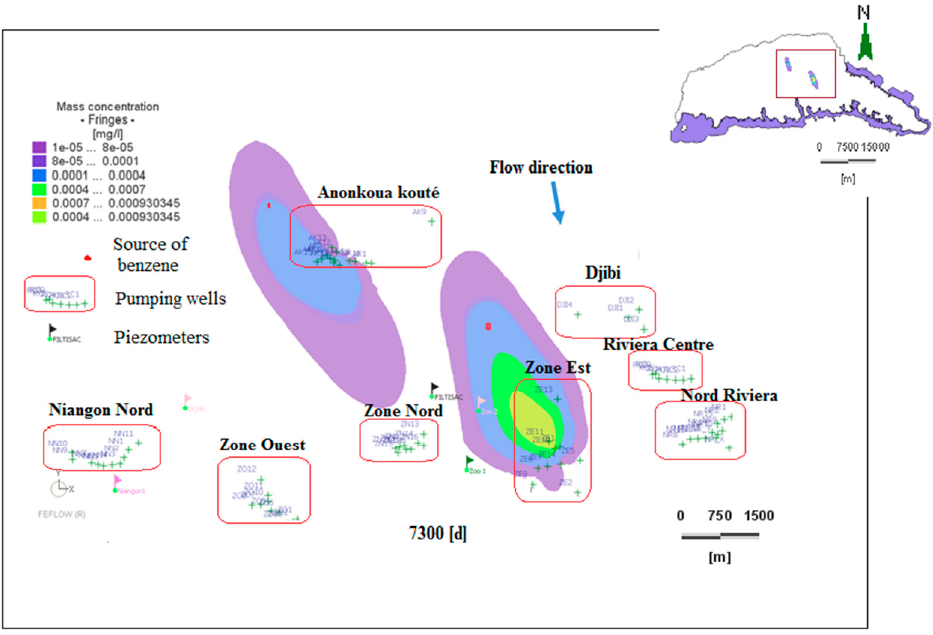
Figure 15. Dissolved benzene plume dispersion at 7300 days (1998).